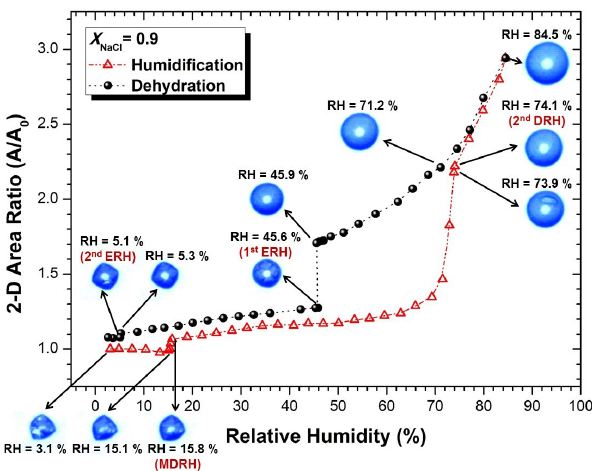
Figure 3. Plot of 2-D area ratio ( A / A 0 ) of a NaCl-rich particle with a seawater-like mixing ratio of X NaCl = 0.9 as a function of RH. The recorded optical images of the particle/droplet along with transition RHs in both humidification and dehydration processes are marked with